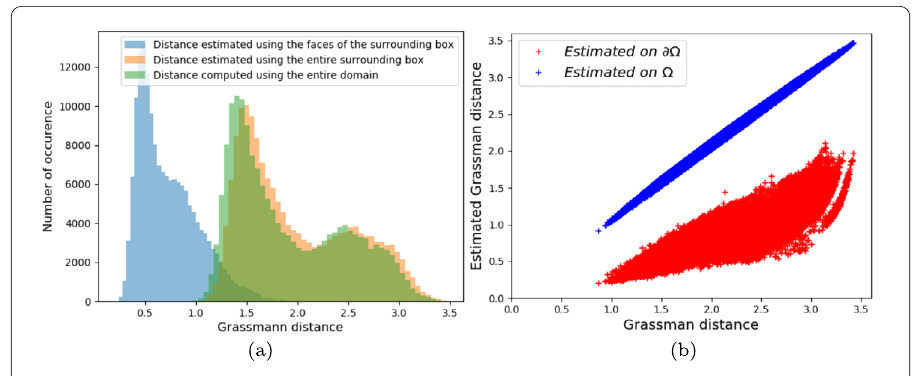
Figure 5 Histograms of the Grassmann distances for defects 1–400 ( a ) and corresponding point-cloud representation ( b ). The distance is estimated using the volume of the surrounding box (cid:5) , the faces ∂(cid:5) of the surrounding box or computed using the entire